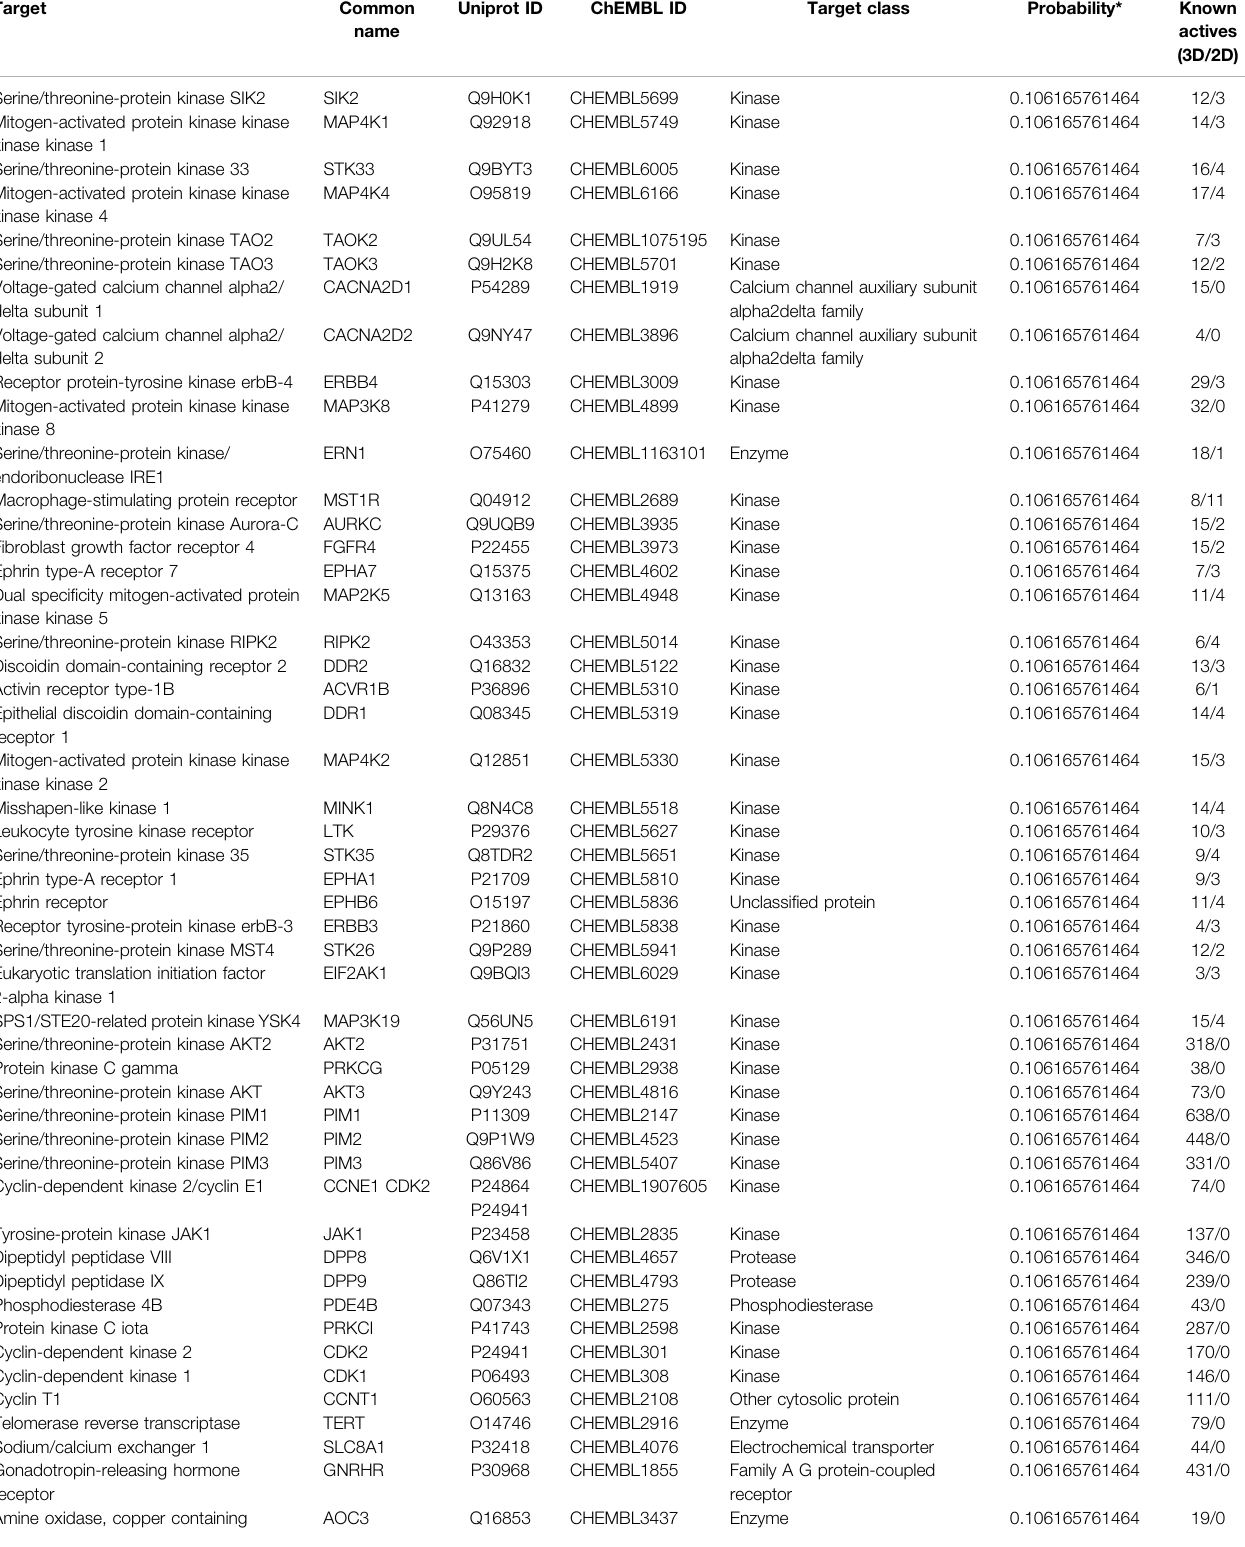
TABLE 2 | ( Continued ) Targets of anlotinib obtained through